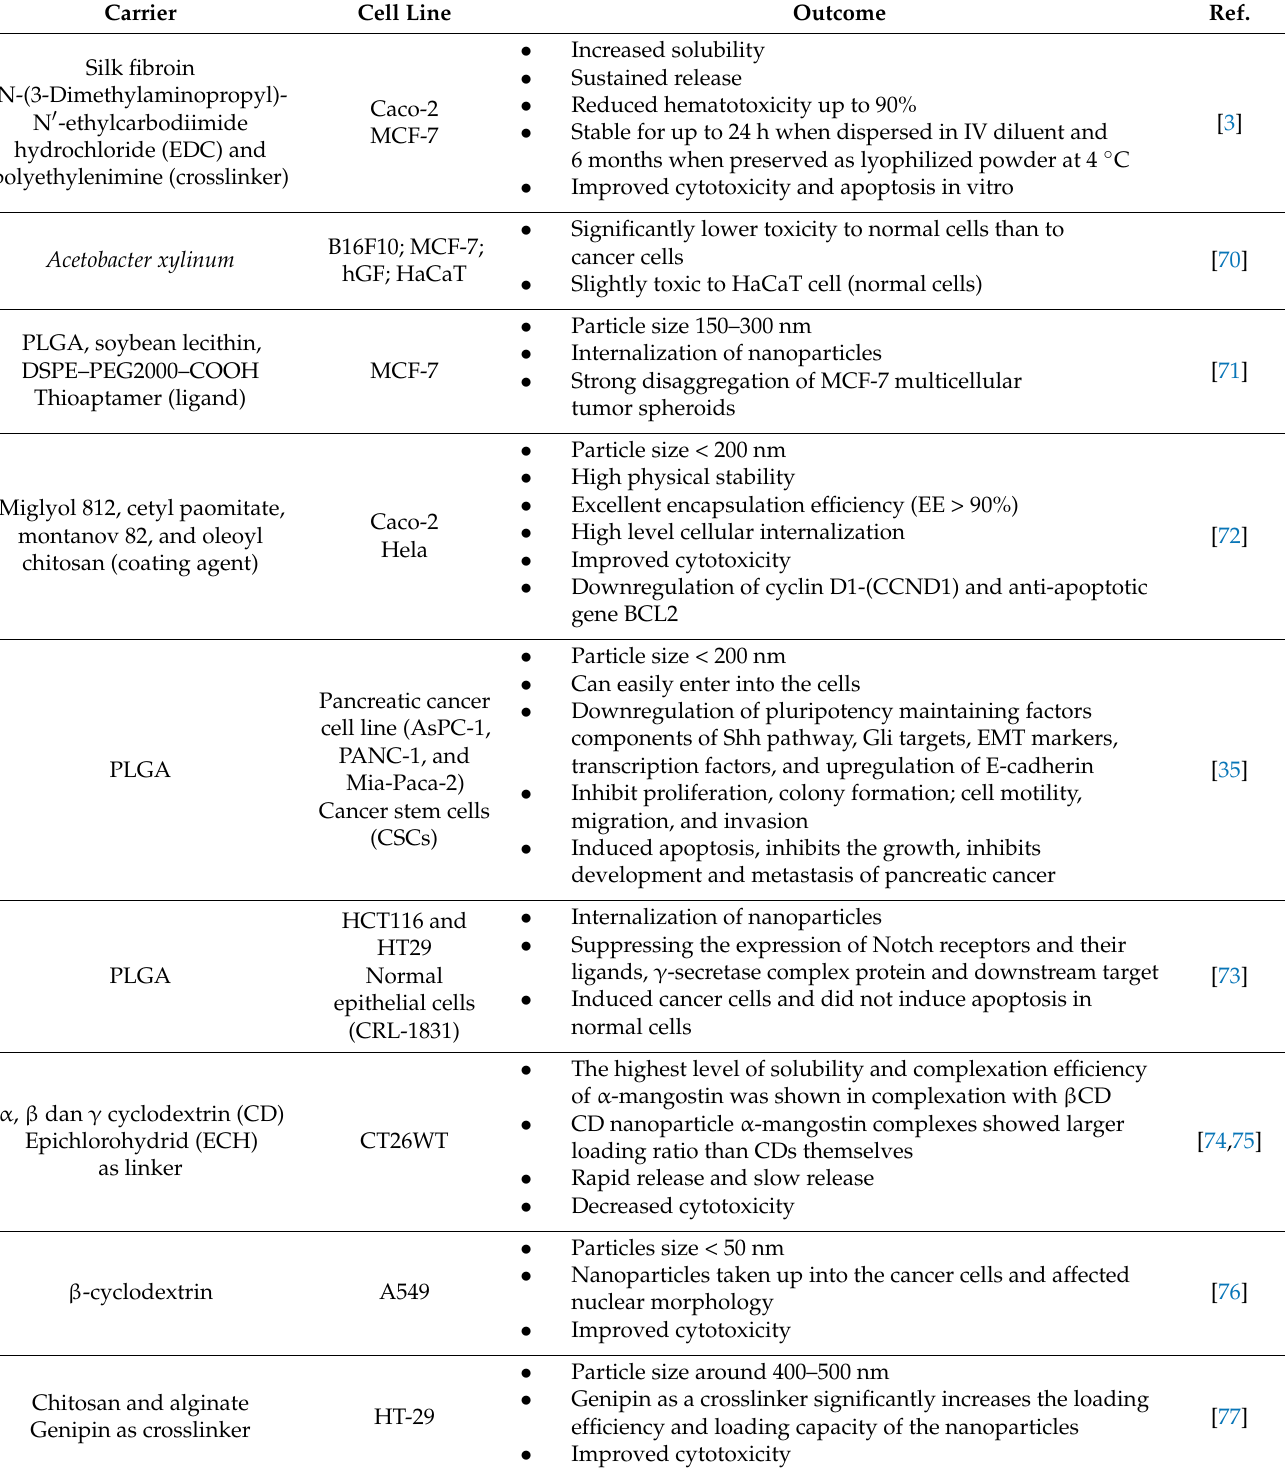
Table 2. Summary of α -mangostin nanoformulations. Carrier Outcome